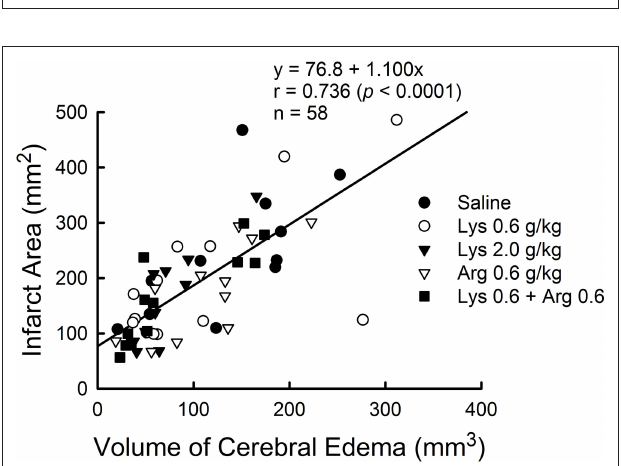
FIgure 6 | reduction of infarct area by oral administration of lysine (Lys) and/or arginine (Arg) in MCAO rats. Infarct area was measured with TTC staining. Note that administration of lysine alone at high dose (2.0 g/kg) or combined administration of lysine and arginine at low dose (0.6 g/kg) significantly suppressed infarct in consistent to the effects on cerebral edema as shown in Figure 2. * p < 0.05, significance compared to the saline-treated control group by ANOVA followed by Fisher’s PLSD test.